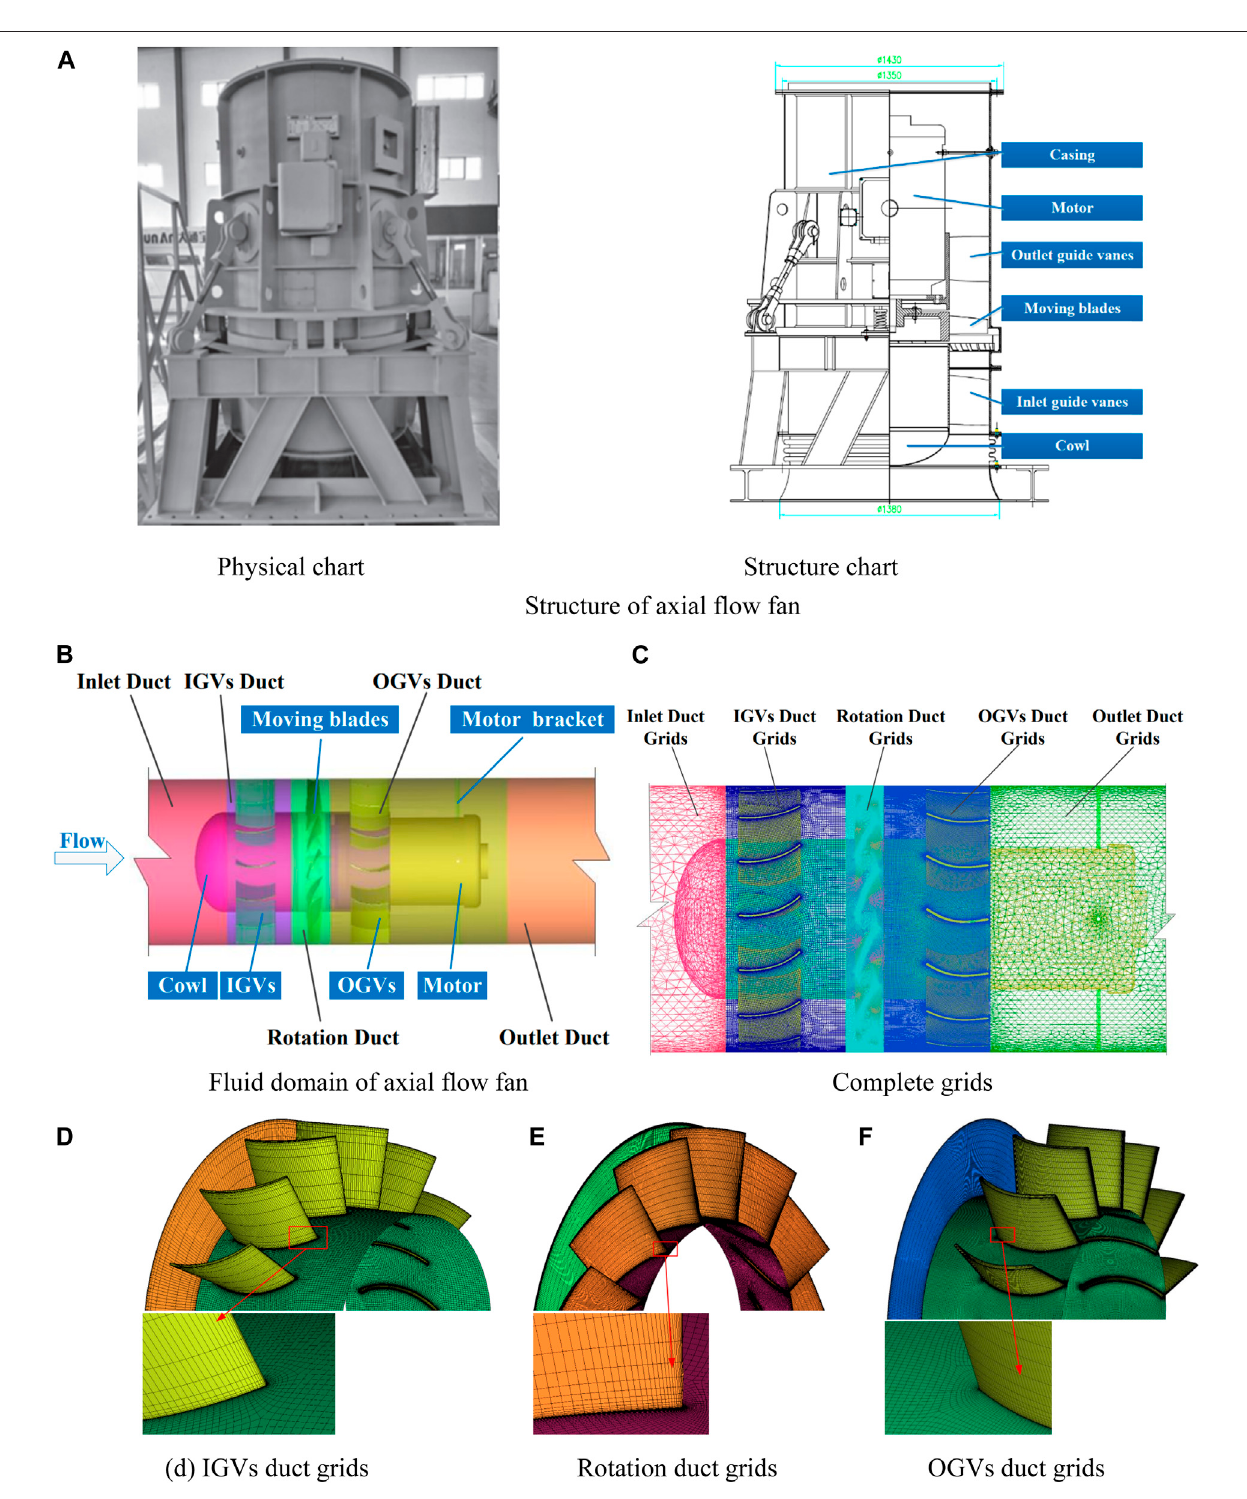
FIGURE 2 | Geometric models and meshes. Physical chart Structure chart (A) Structure of axial fl ow fan (B) Fluid domain of axial fl ow fan (C) Complete grids (D) IGVs duct grids (E) Rotation duct grids (F) OGVs duct grids.